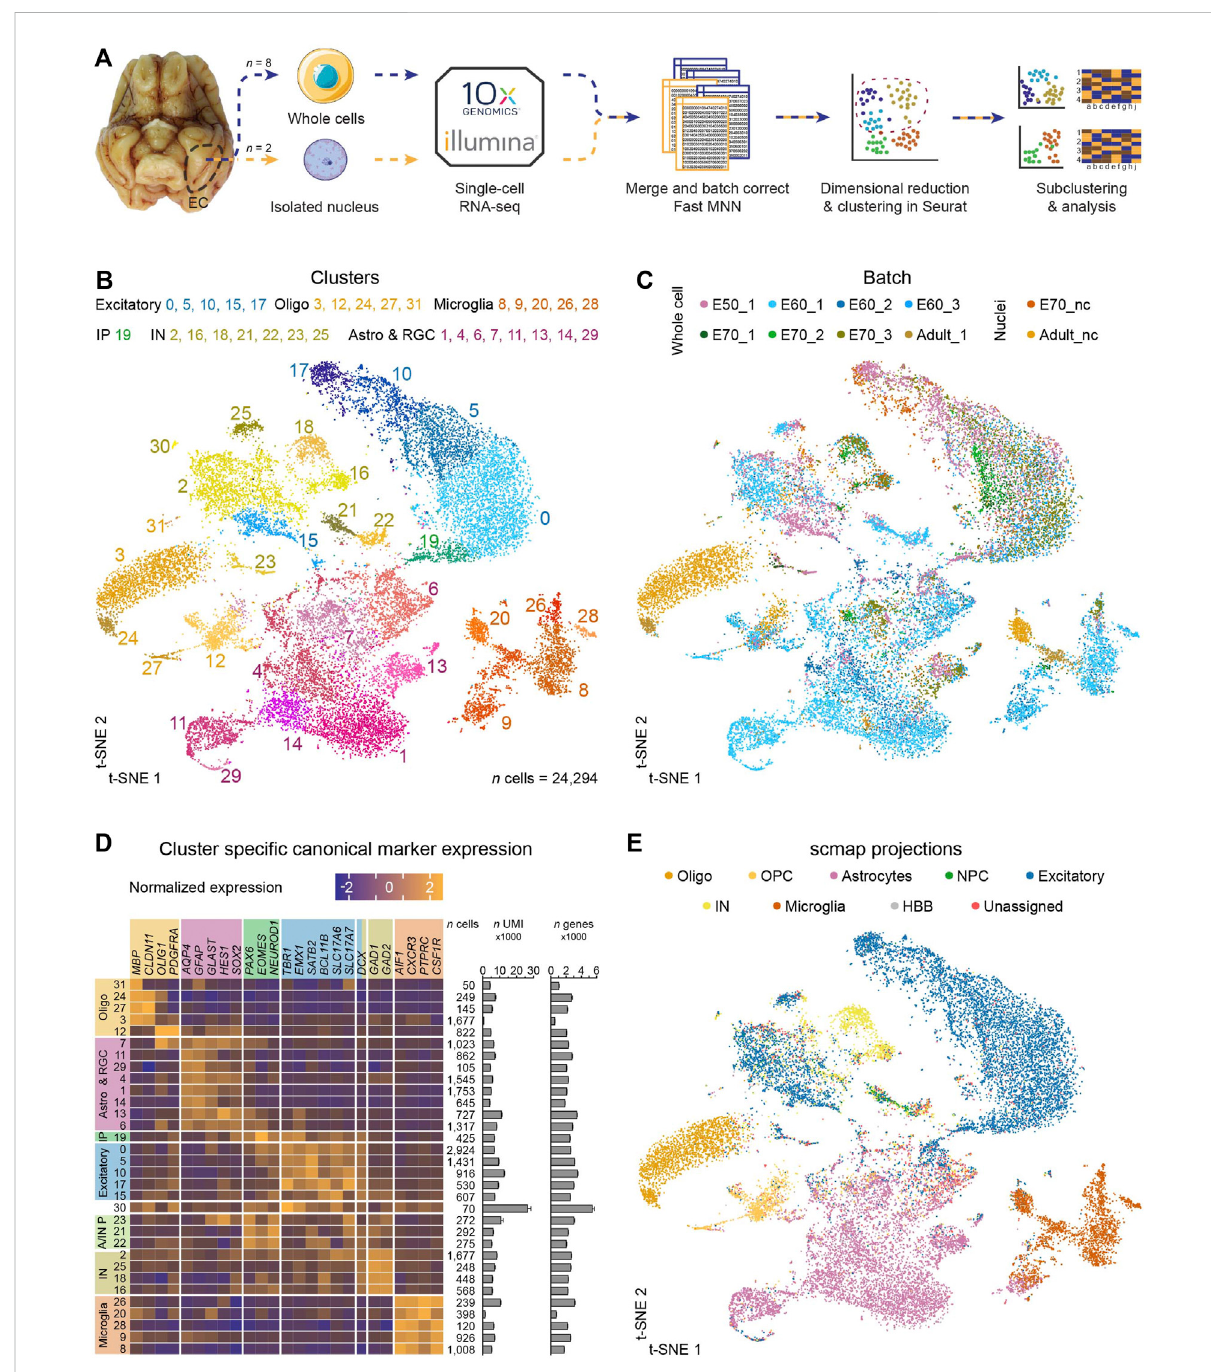
FIGURE 1 Single-cell pro fi ling of the entorhinal cortex reveals thirty-two distinct cell clusters of major cell type populations. (A) The computational pipeline includes ten batches of single-cell and single-nuclei isolated cells from E50, E60, E70 and P75 which were captured using the 10X genomics platform. Batches were merged using the Fast MNN approach and dimensional reduction and clustering were performed in Seurat followed by subclustering and analyses of selected clusters. (B) A t-SNE plot of 24,294 cells merged from all timepoints revealed thirty-two distinct populations following FastMNN batch correction. Oligodendro-glia/-cytes (Oligo), astrocytes and radial glia (Astro & RGC), intermediate progenitors (IP), excitatory neurons (Excitatory), astrocyteandinterneuronprogenitors(A/INP)andmicroglia(Microglia) (C) t-SNEplotannotatedbybatchdemonstratesgoodintegrationofsubtypeswithin sameagesfollowing correctionby FastMNNof the10datasets(pre-batchcorrectionshownin SupplementaryFigureS7E). (D) Analysisof canonicalmarker genesresultedincategorizationofseveralOligo,Astro&RGC,IP,Excitatory,A/INPandMicrogliaclusters.Thenumber( n )ofcells,meanUMIcounts(unique transcripts)andmeannumberofdifferentexpressedgenesforeachclusterarealsorepresented.ErrorbarsdenotetheSD. (E) Projectionofthedatasetonto analready-annotatedhumanfetalprefrontalcortexandhumanmedialtemporalgyrussingle-celldatasetconsolidatesmarkergene-drivenannotationofthe dataset. Abbreviations: NPC, neural progenitor cells; HBB, marker expressed in human blood